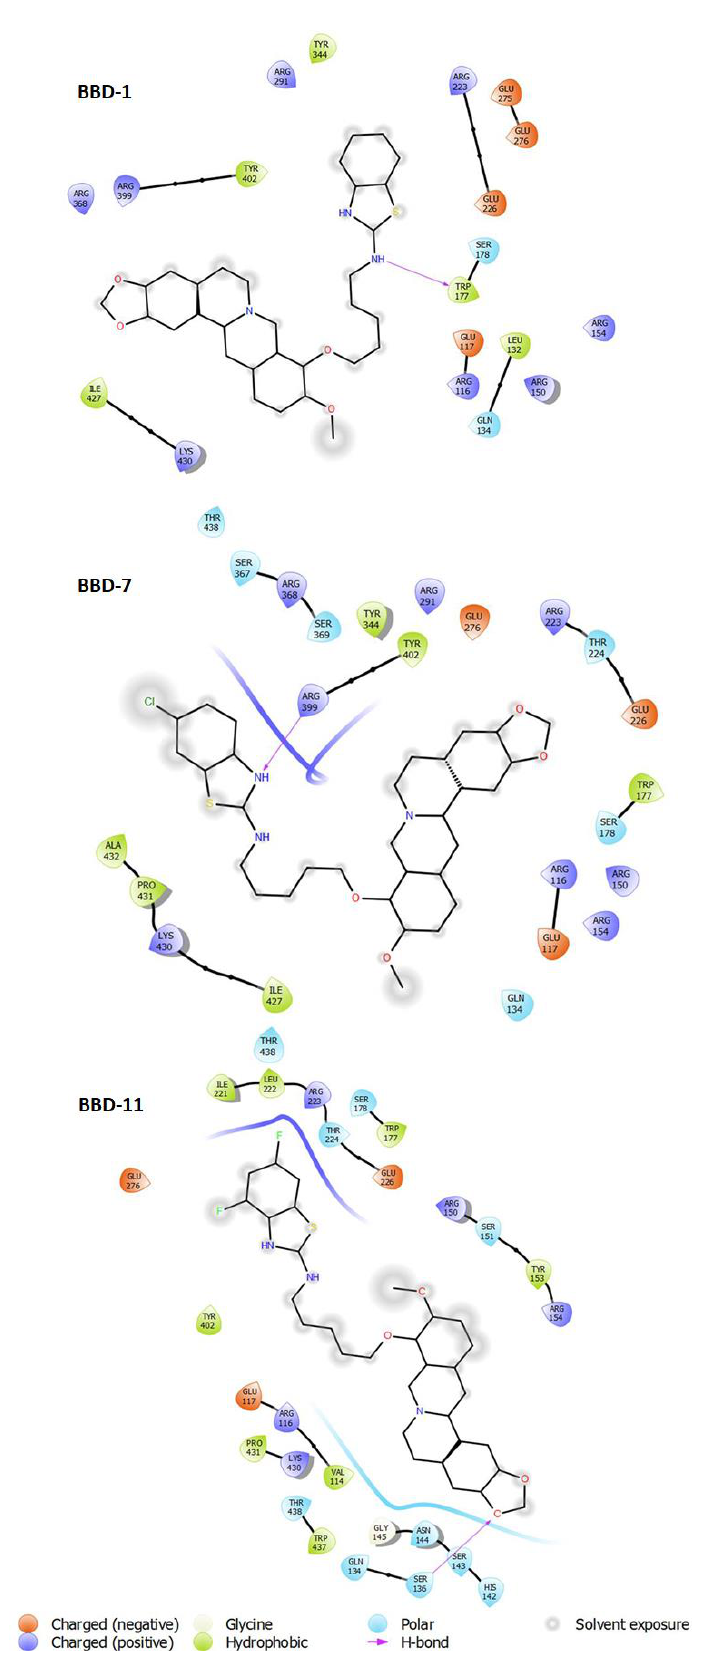
Figure 3. Overall binding interactions of BBD-1, BBD-7 and, BBD-11 were calculated in five Angstrom distances from the influenza NA subunit (4WA4). The ligand is represented in the best-scored pose.